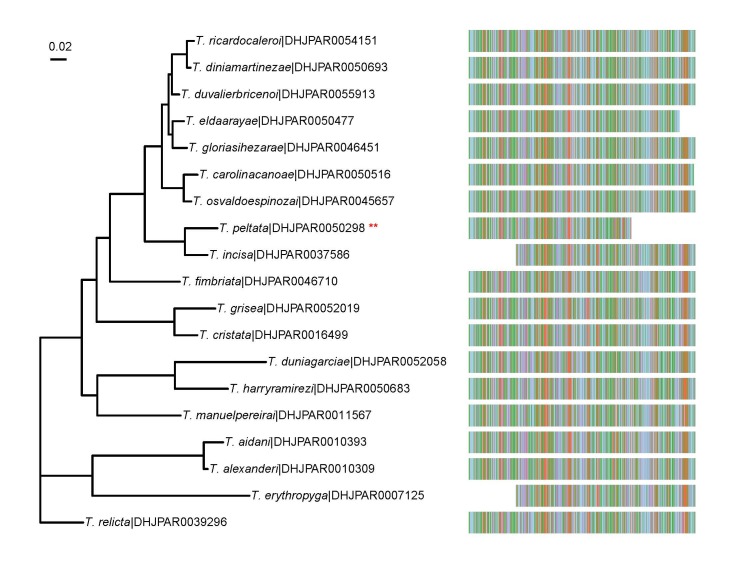
An unrooted phylogenetic tree for nineteen species of ACG Telothyria inferred by using the Maximum Likelihood (ML) method based on the General Time Reversible model (Nei and Kumar 2000) conducted in MEGA X (Kumar et al. 2018) and presented using the ggtree package (Yu et al. 2016) in R (Team 2019). Tip labels are species names and the DHJPAR accession for the holotype and are associated with an image of the DNA barcode (with coloured bars representing the A (green), T (blue), C (purple) or G (red). Exceptions to this pattern are first for T.
relicta (where the holotype has not been sequenced) and for T.
peltata (marked with two red asterisks) where the DNA barcode is not known and what has been included in this ML tree is pseudogene amplicon that has been amplified for all three known samples of this species.